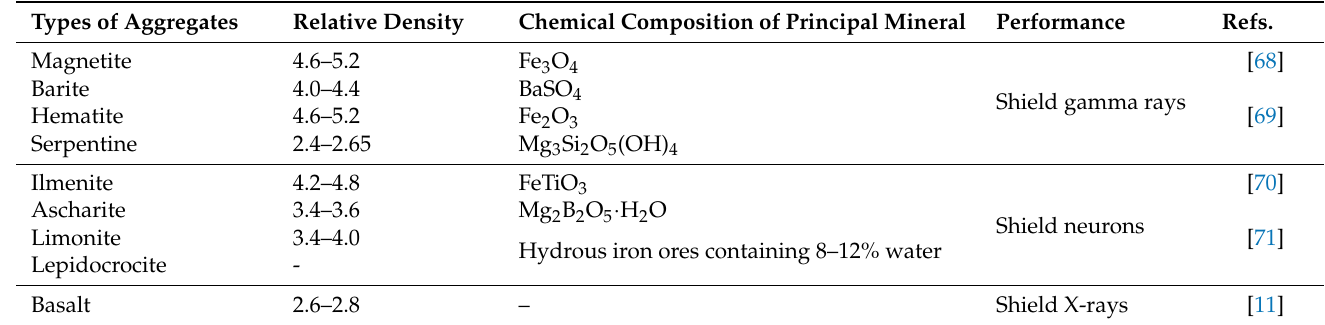
Table 1. Composition, performance, and density of heavyweight